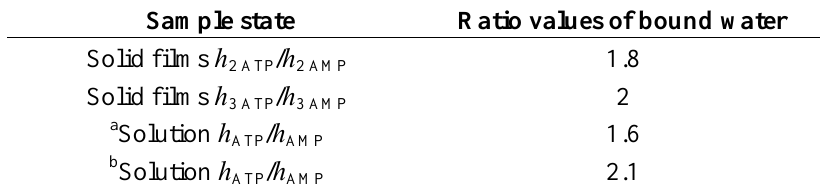
Table 2. Ratio values of bound water in solid films of AMP and ATP and in solution ( a this study) and ( b from